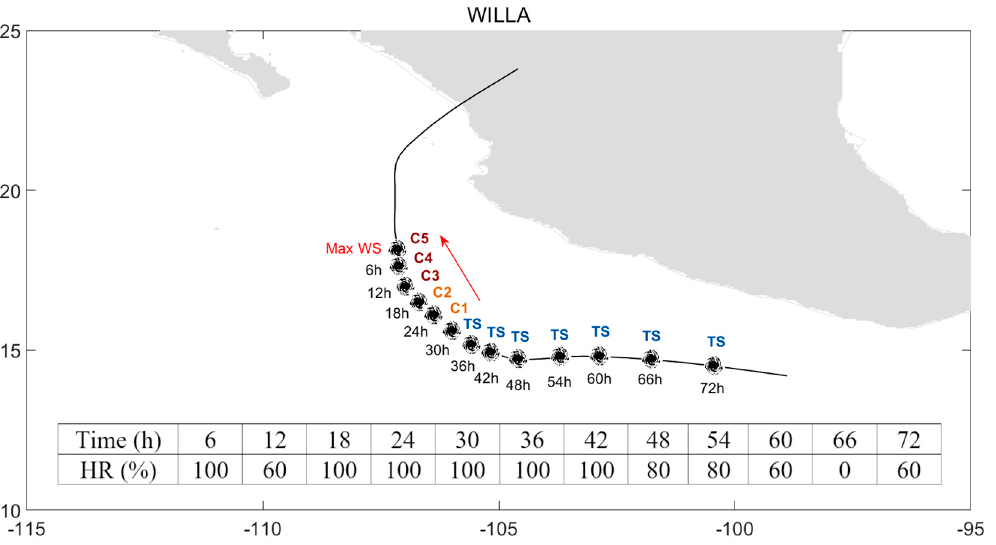
Figure 8. As in Figure 4, but for hurricane Willa (NE Pacific Ocean, 20–24 October 2018). Here, the TS was formed on 20 October 2018, at 12:00 UTC and it reached the Max WS on 22 October 2018, at 06:00 UTC.